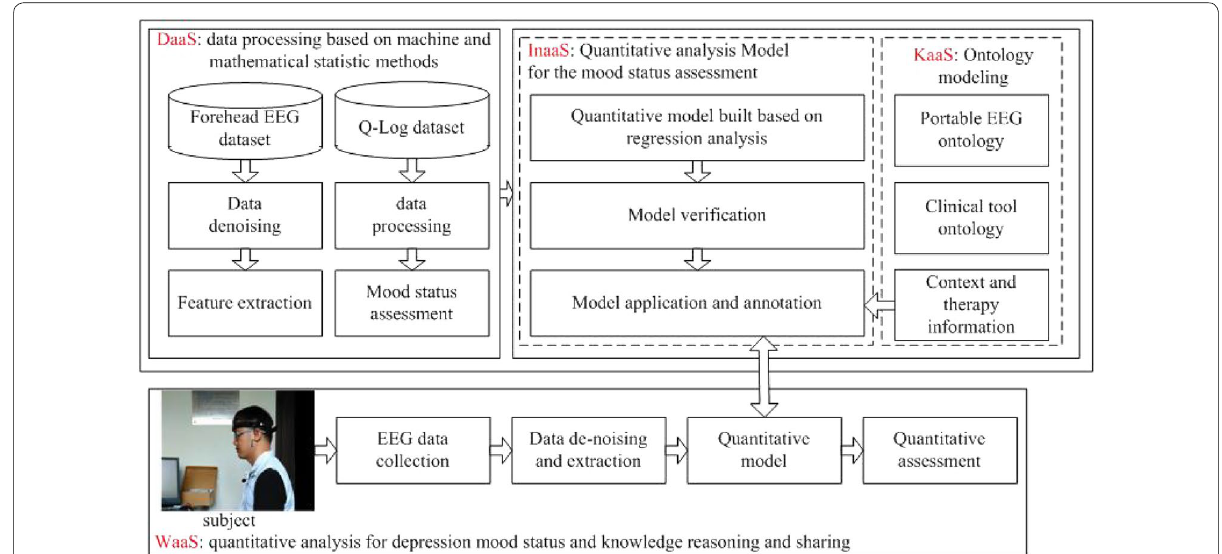
Fig. 1 Technical route for quantitatively analyzing the depressive mood status based on forehead EEG and Q-Log